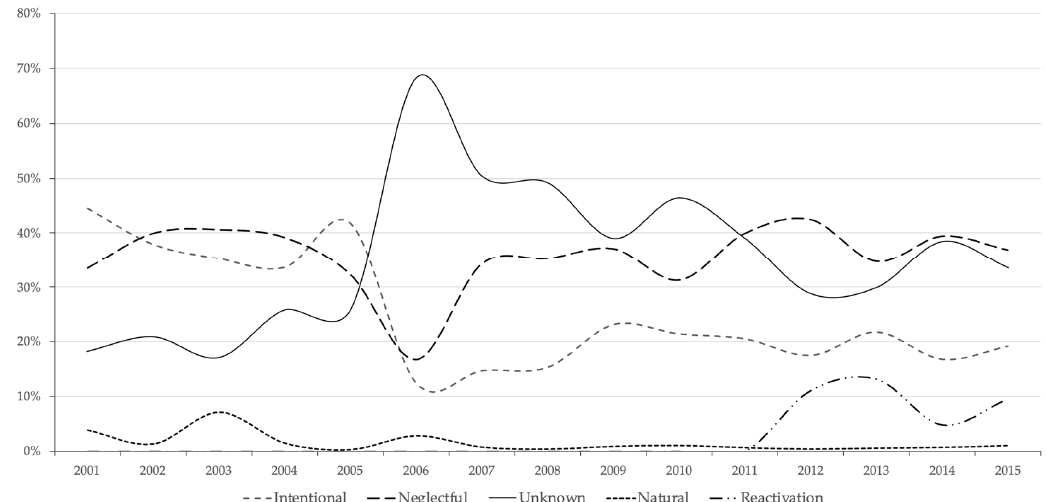
Figure 4. Causes of rural fires in Portugal between 2001 and 2015 (adapted from http://www.icnf.pt/, accessed on 12 January 2022).